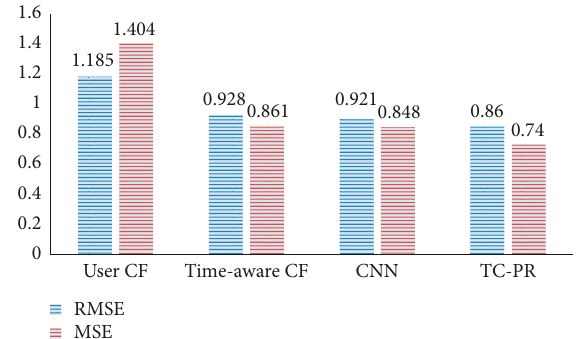
Figure 7: The performance comparison of four recommendation